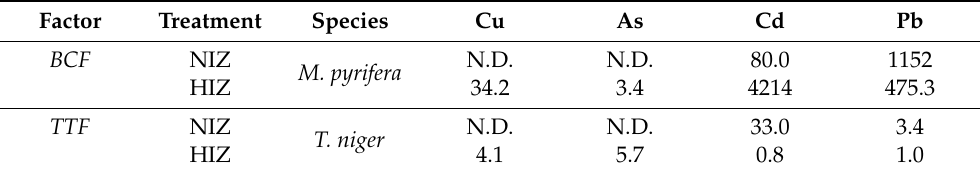
Table 2. BCF and TTF for Cu, As, Cd, and Pb in Macrocystis pyrifera /water column and T. niger/M. pyrifera . N.D. = the concentration of the metal is below the limit of detection, NIZ = non-impacted zone, and HIZ = highly impacted